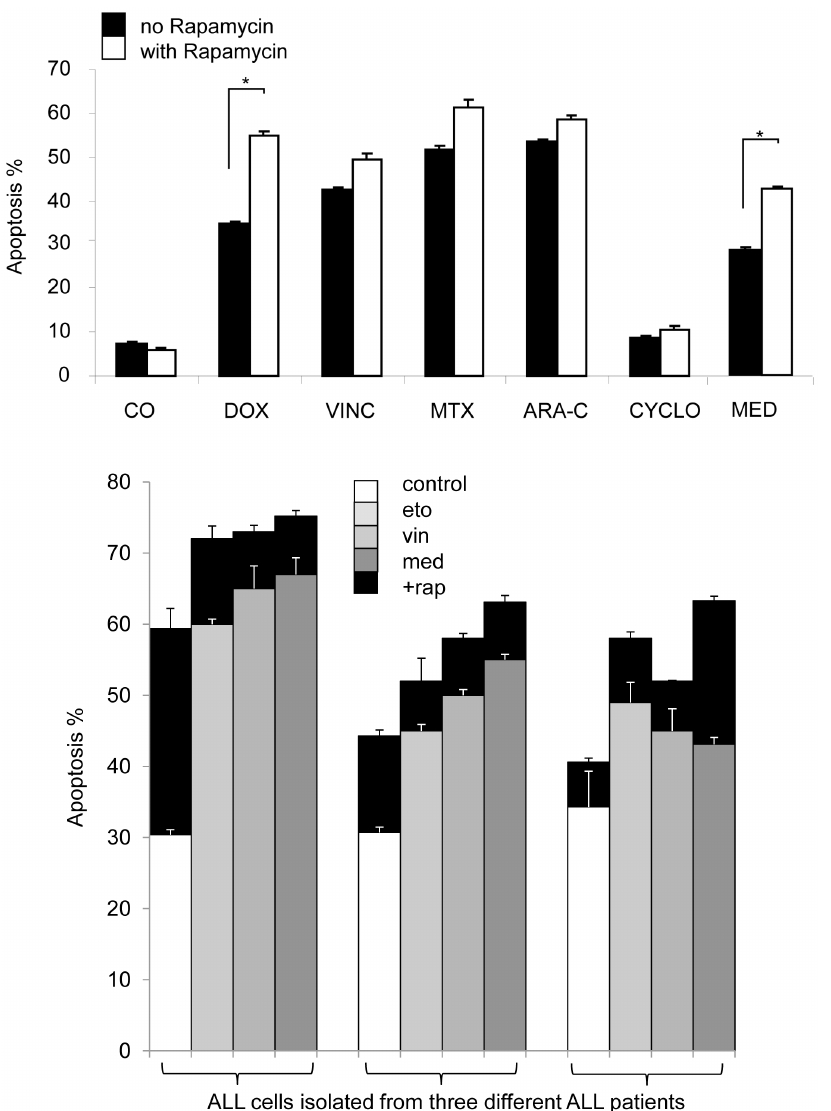
Figure 5. Rapamycin increases the apoptotic effect of several chemotherapeutics in leukemia cells invitro (flow cytometry). (a) The apoptotic effect of rapamycin (50 ng/ml) combined with other drugs. Nalm6 cells were treated for 72 h. (DOX: doxorubicin, 100 nM; VINC: vincristin, 3 nM; MTX: methotrexate, 20 nM; ARA-C: cytarabine, 10 ng/ml, CYCLO: cyclophosphamide, 500 nM; MED: methyl-prednisolone, 100 nM.) *- p , 0,05 . (b) The apoptotic effect of rapamycin (rap, 50 ng/ml) combined with methyl-prednisolone (med; 100 nM), vincristin (vin; 3 nM) and etoposide (eto; 10 nM) treatment in isolated childhood BCP-ALL cells from three different patients, treated for 24 h. (The first two samples were cultured from cells isolated at diagnosis, the third one at